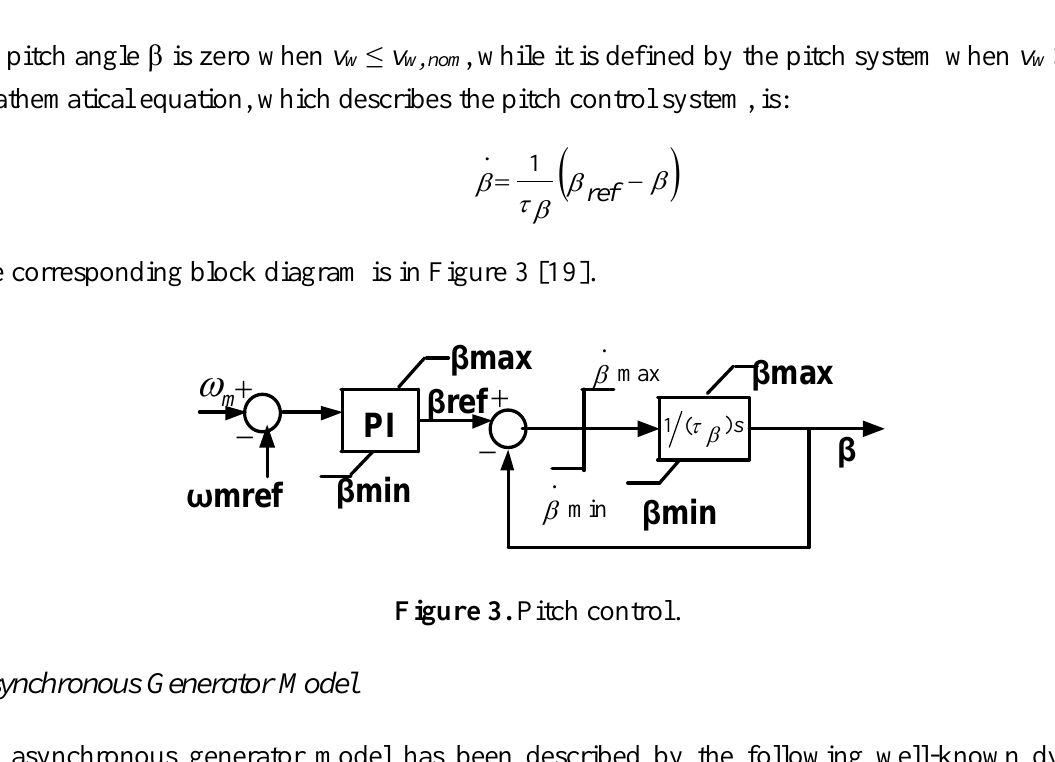
Figure 2. Wind turbine l.